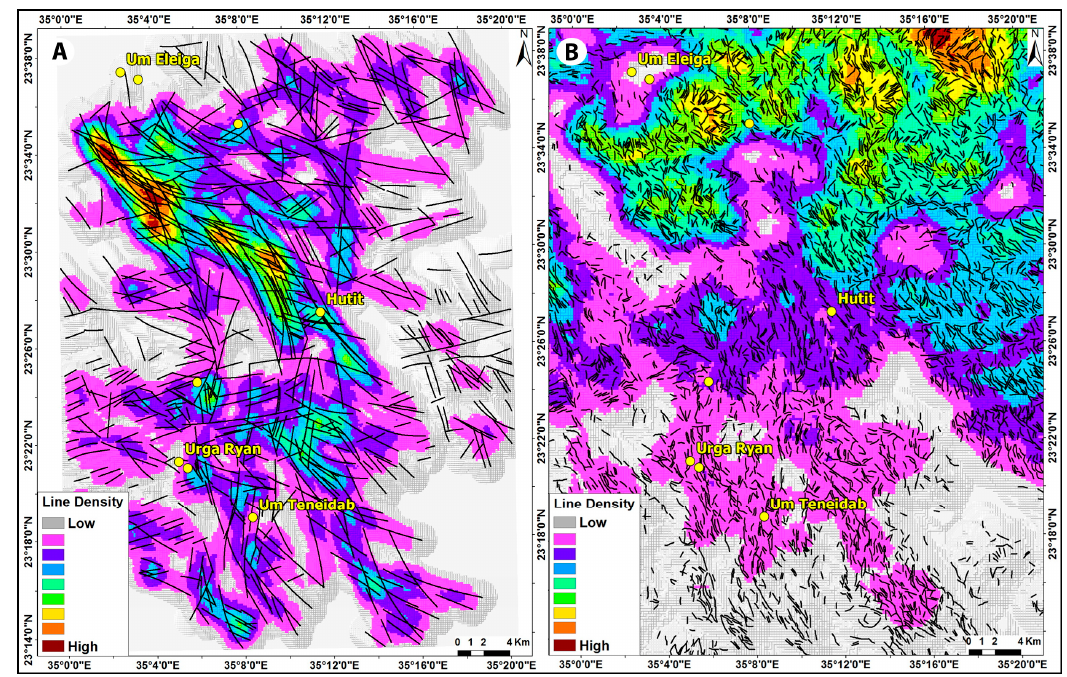
Figure 10. Density maps of the extracted structural lineaments in the study area. ( A ) Line density map of manually extracted lineaments aided by edge enhancement and directional filtering techniques; ( B ) line density map of lineaments extracted automatically by the LINE algorithm (see the text for more details).